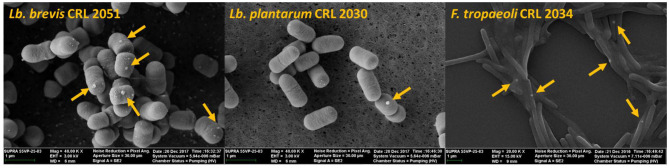
SEM microphotographs of selenized cells after 24-h incubation at 30°C in MRS or MRSf.